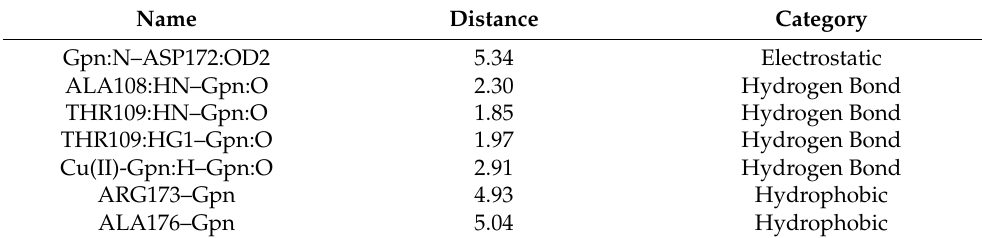
Table 5. The Gpn–serotonin interaction results by Discovery Studio.